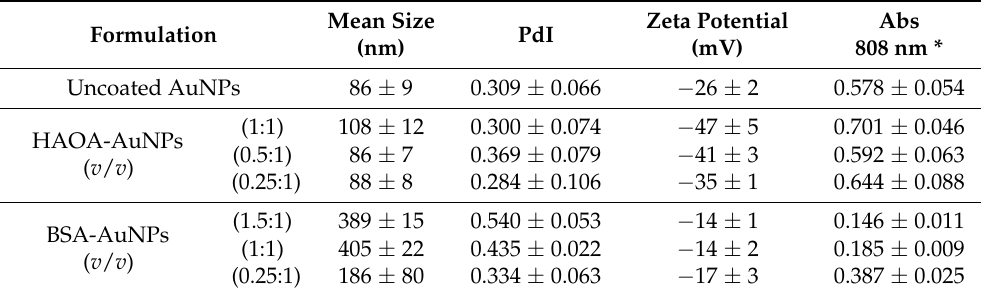
Table 1. Mean size, polydispersity index (PdI), zeta potential and absorbance at 808 nm of uncoated AuNPs and different ratios ( v / v ) of synthesized HAOA-AuNPs and BSA-AuNPs. Zeta Potential Abs Mean Size PdI Formulation (mV) 808 nm * (nm) Uncoated AuNPs 86 ± 9 0.309 ± 0.066 − 26 ± 2 0.578 ± 0.054 (1:1) 108 ± 12 0.300 ± 0.074 − 47 ± 5 0.701 ± 0.046 HAOA-AuNPs (0.5:1) 86 ± 7 0.369 ± 0.079 − 41 ± 3 0.592 ± 0.063 ( v / v ) (0.25:1) 88 ± 8 0.284 ± 0.106 − 35 ± 1 0.644 ± 0.088 (1.5:1) 389 ± 15 0.540 ± 0.053 − 14 ± 1 0.146 ± 0.011 BSA-AuNPs (1:1) 405 ± 22 0.435 ± 0.022 − 14 ± 2 0.185 ± 0.009 ( v / v ) (0.25:1) 186 ± 80 0.334 ± 0.063 − 17 ± 3 0.387 ±